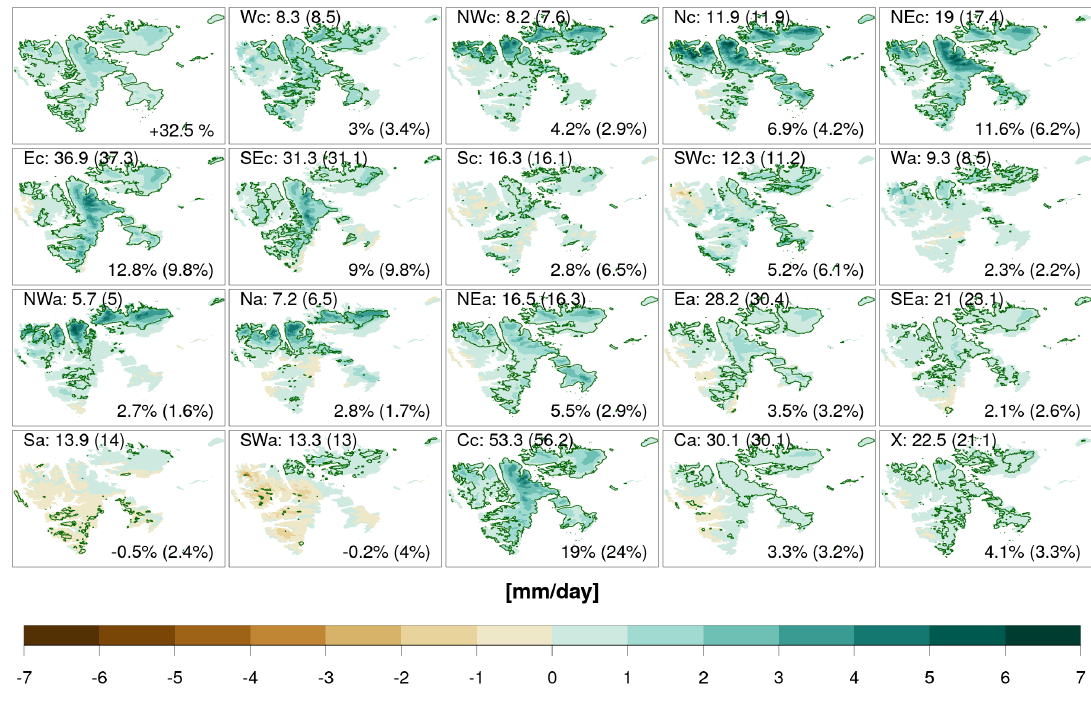
Figure 10. Annual mean precipitation change from 1971–2000 to 2071–2100 (top left) and its decomposition into single weather types. Statistically significant changes are outlined. For the annual mean, the number in the bottom right corner gives the mean increase. For the weather types, the numbers give the contributions to the change and the contribution to the future mean precipitation (in parentheses), respectively. In the top left corner, the frequencies (number of days per year) for the future and current climate (in parentheses) are given.